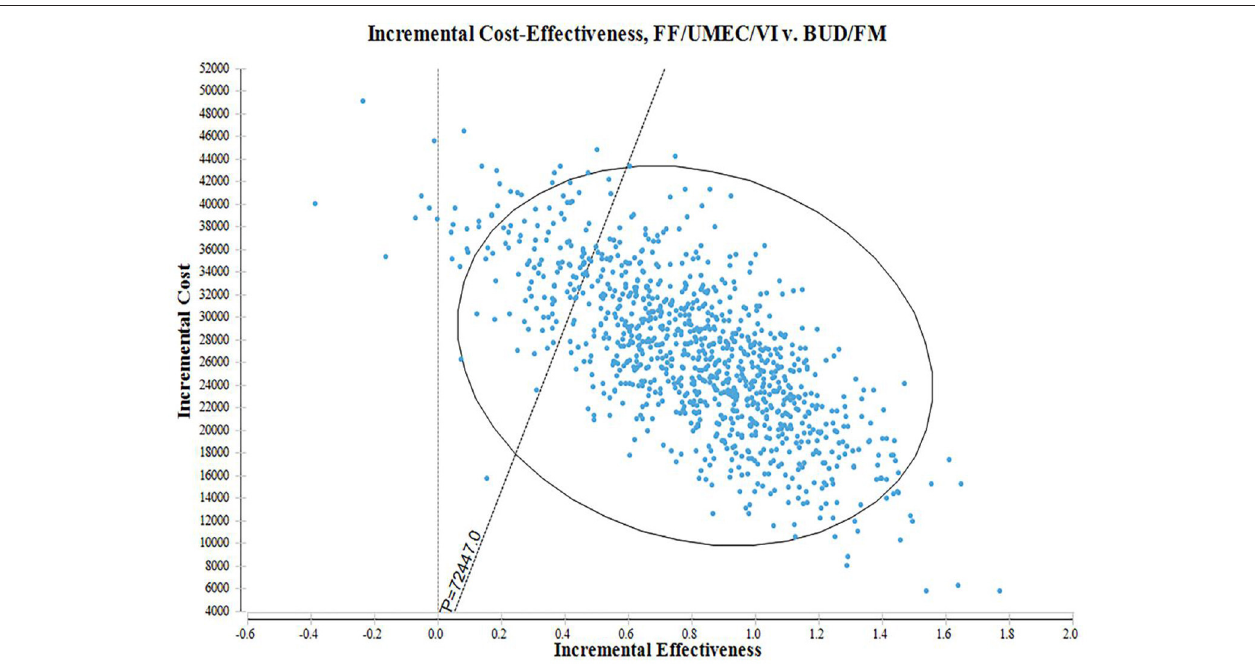
FIGURE 3 | Monte Carlo simulation pseudo-scatter plot. Dotted line: WTP = U 72,447/QALY.